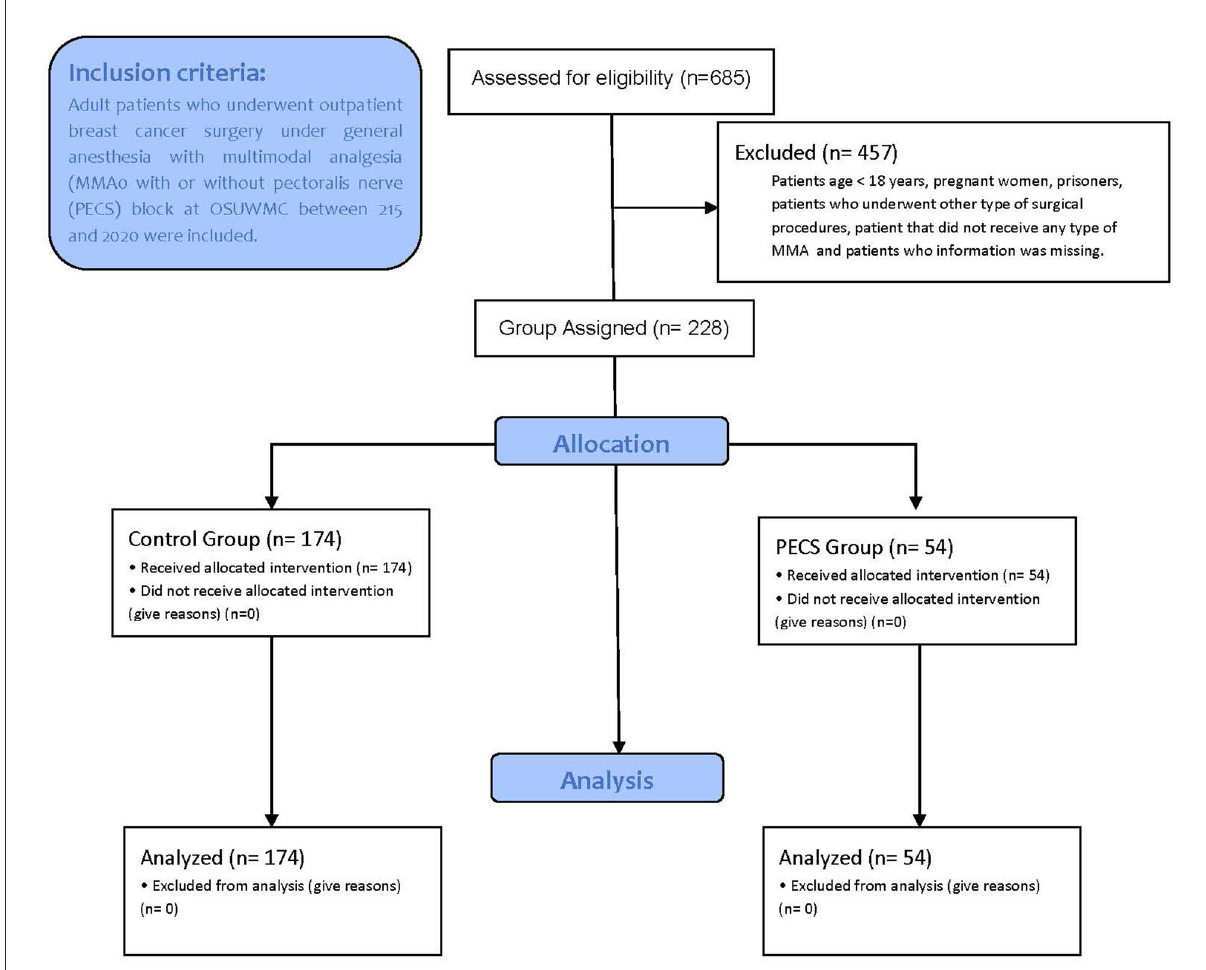
FIGURE1 CONSORT flow diagram for subjects included in the study. N, number of participants; MMA, multimodal analgesia.